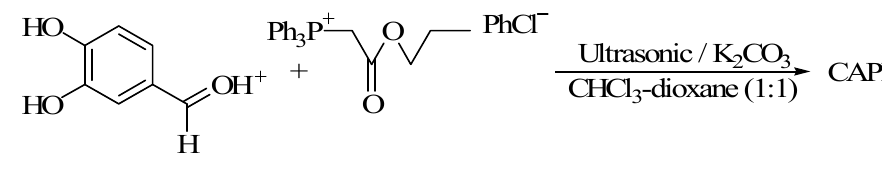
Figure 5. The scheme of witting